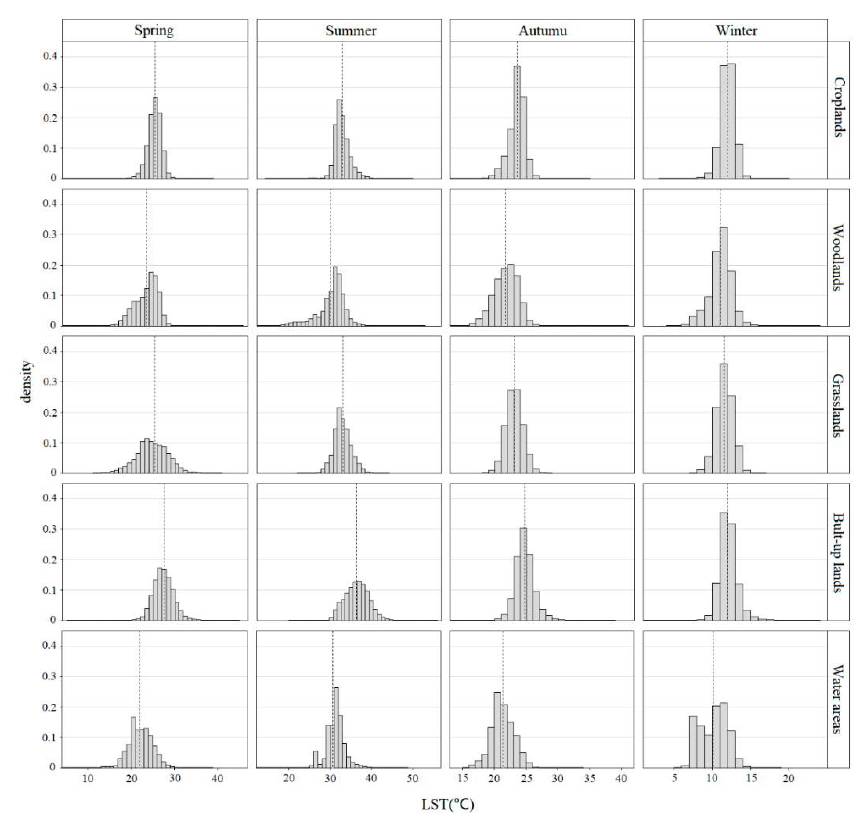
Figure 7. Probability density histograms of Wuhan’s LST for each season and for each land cover. The dotted vertical lines indicate the mean LST for each